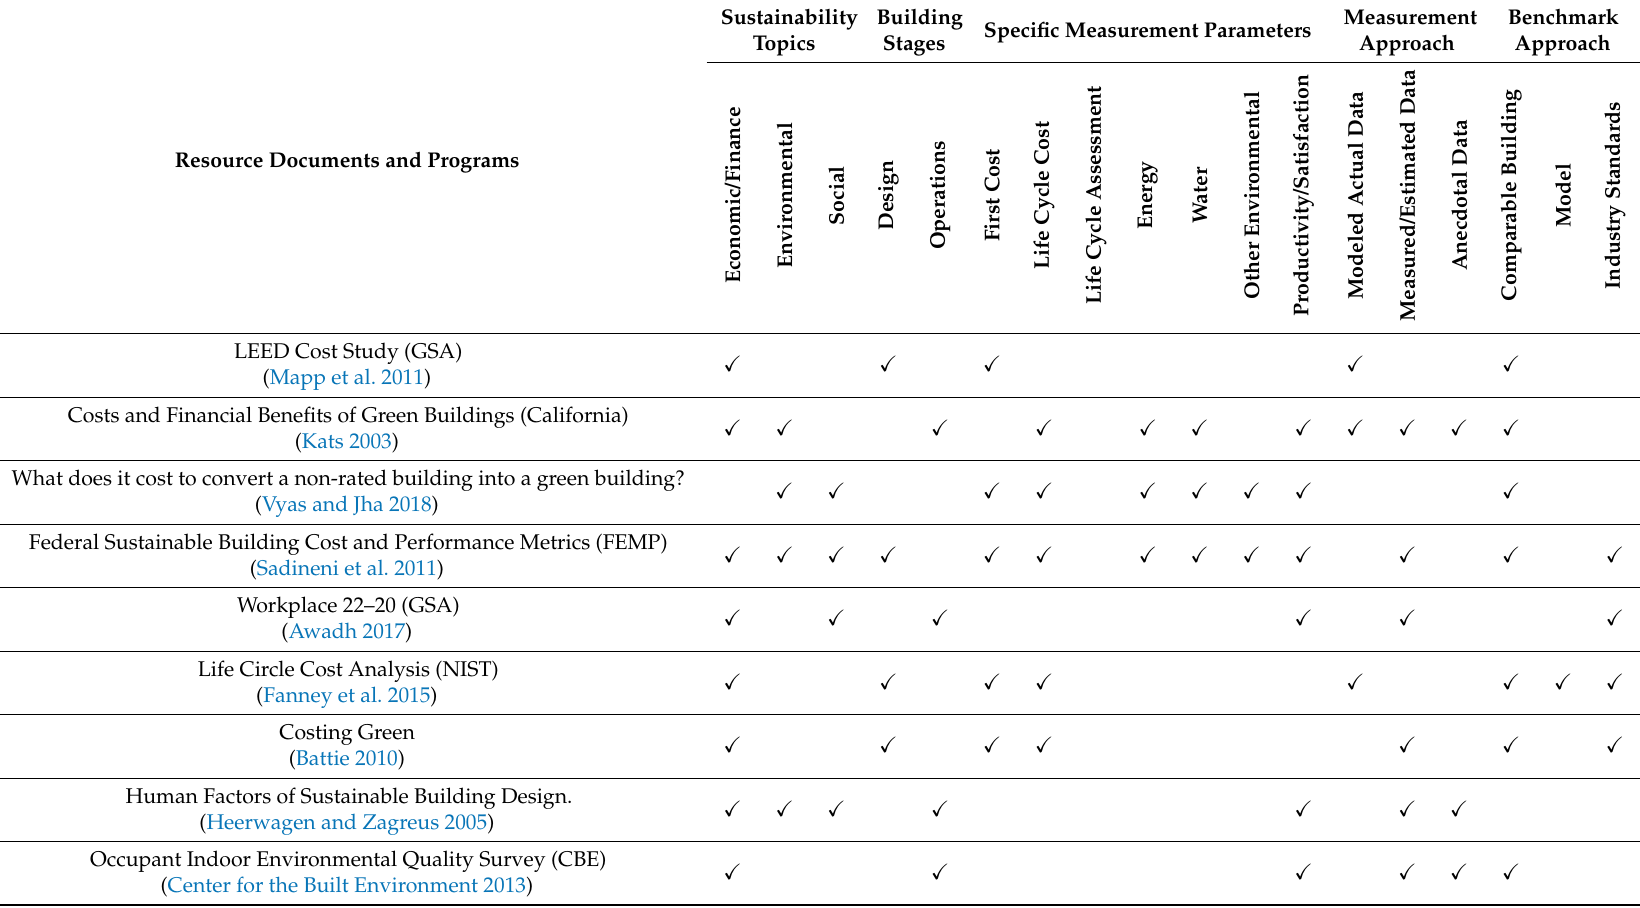
Table 4. Available Studies on the Costs Benefits of Sustainable Design.